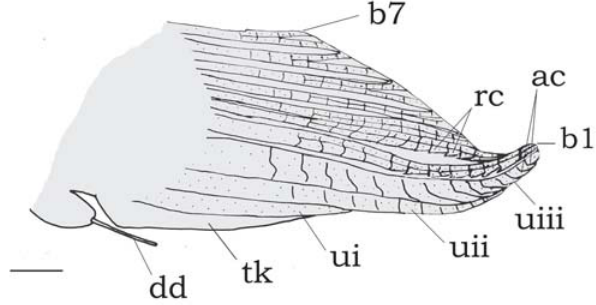
Fig. 24. Male modified anal fin of Tatia galaxias , MCNG 25983, 85.6 mm SL. Left side lateral view. Abbreviations: ac , antrorsely curved denticulation; b1 , branched first ray; b7 , branched seventh ray; dd , deferent duct; rc , retrorsely curved denticulation; tk , tegumentary keel; ui , unbranched first ray; uii , unbranched second ray; uiii , unbranched third ray. Scale bar = 1.0